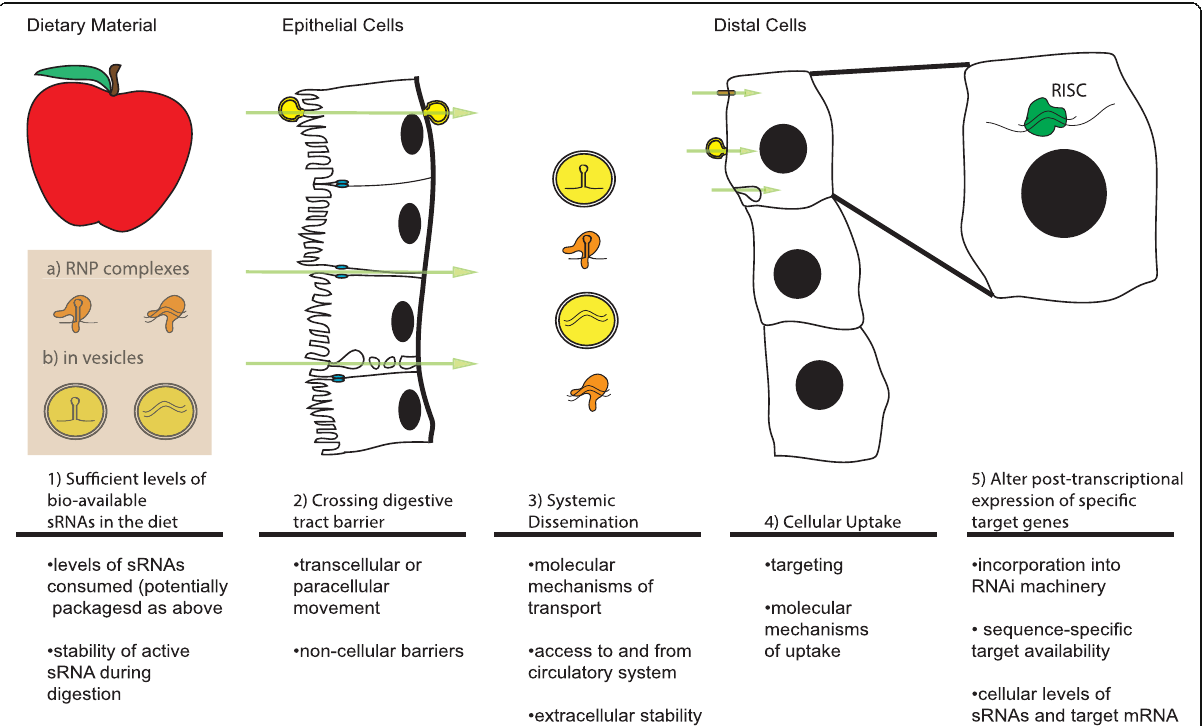
Fig. 2 Critical steps for successful alteration gene expression of an ingesting organism by dietary sRNA (adapted from [64]). ( 1 ) Sufficient levels of bio-available sRNA in the diet (potentially packaged ( a ) in ribonucleoprotein (RNP) complexes or ( b ) in vesicles); ( 2 ) crossing the digestive tract barrier; ( 3 ) systemic dissemination; ( 4 ) cellular uptake; and ( 5 ) alteration of post-transcriptional expression of specific target genes by the RNA- induced silencing complex (RISC, green